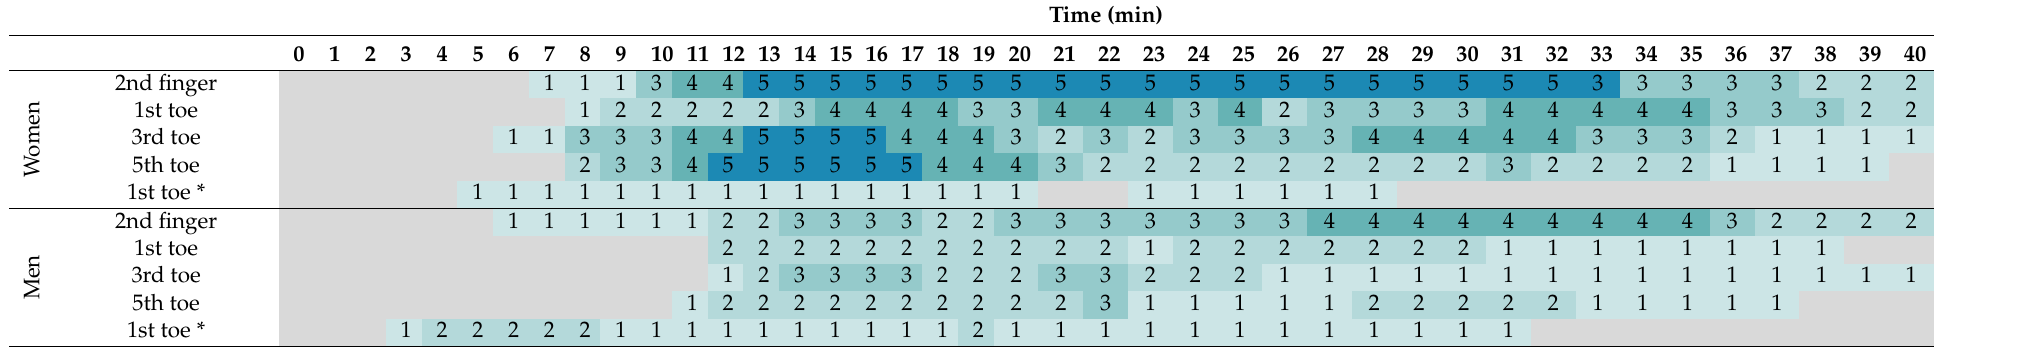
Table 4. Heat map presenting the number of participants that demonstrated a CIVD reaction for each minute of the cold immersion during exposure in the hot environment (34 ± 1 ◦ C). Colors indicate frequencies. Gray color indicates lack of